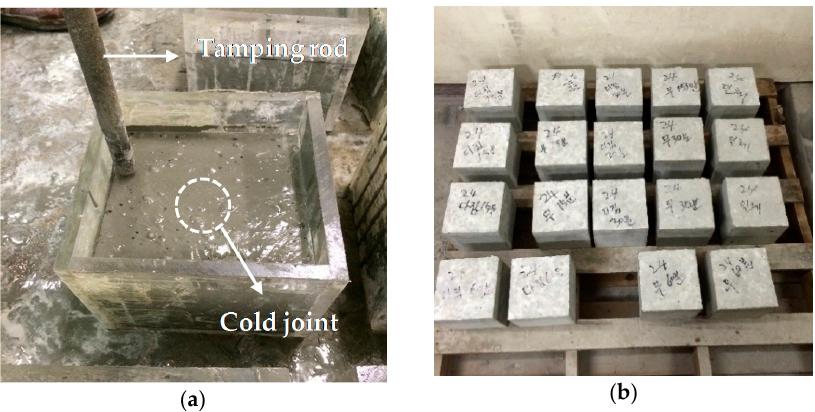
Figure 3. Manufacturing of specimens for direct shear test: ( a ) tamping of the specimen, prior to the second pouring; and ( b ) specimens after removal.